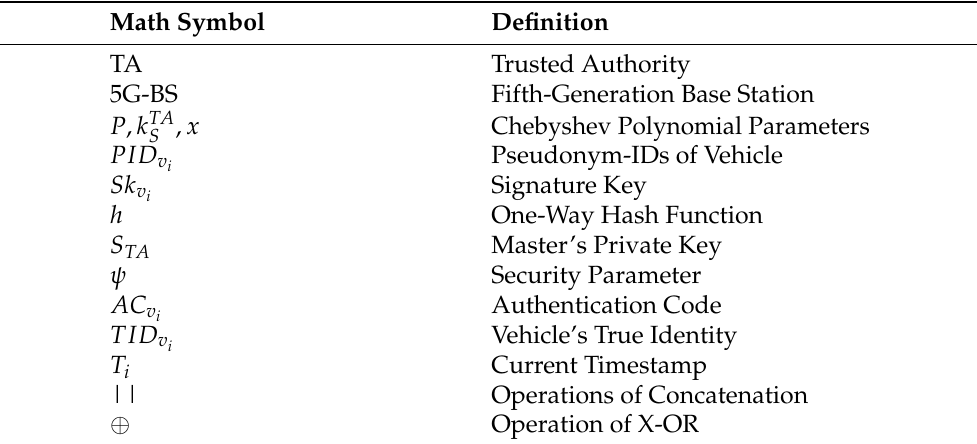
Figure 2. Five Phases of Our Work. Table 2. Math Symbols Used and Their